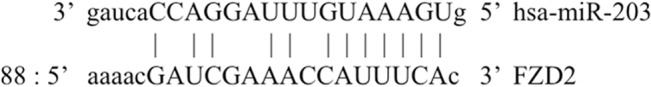

miR-203 targeted the FZD2 gene.The FZD2 3′-UTR sequence and complementary miR-203-binding sequences are shown.